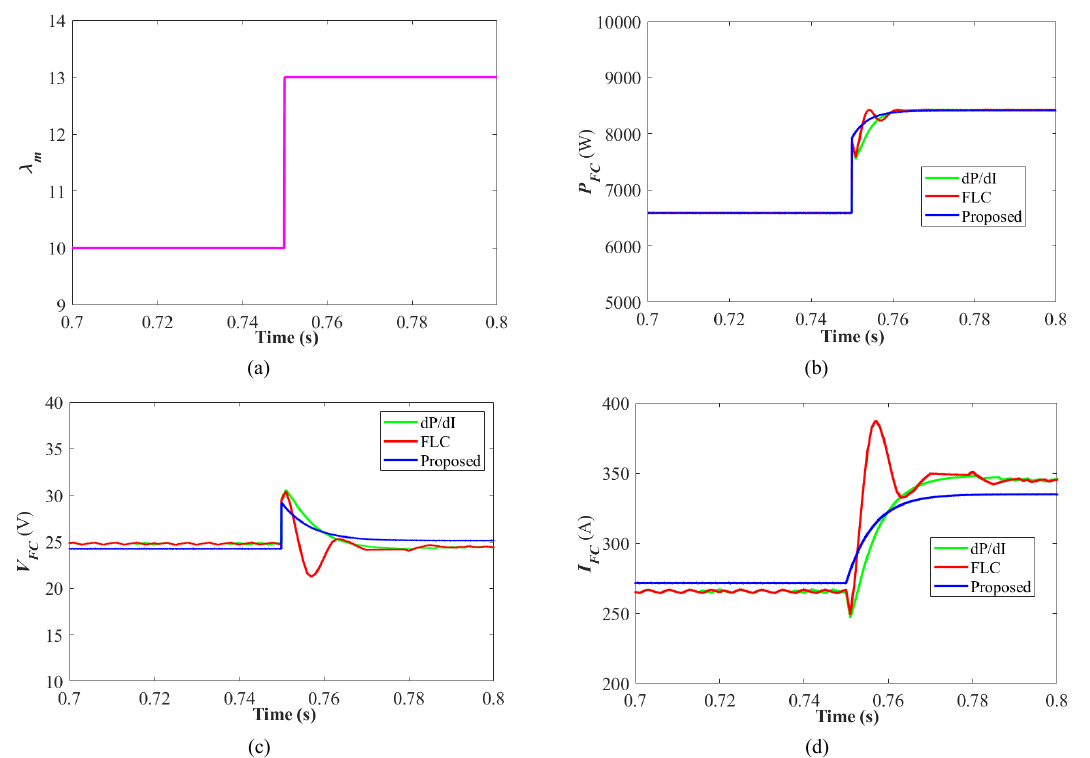
Figure 14. Results and comparisons at scenario 2: ( a ) λ m ; ( b ) P FC ; ( c ) V FC ; ( d ) I FC .